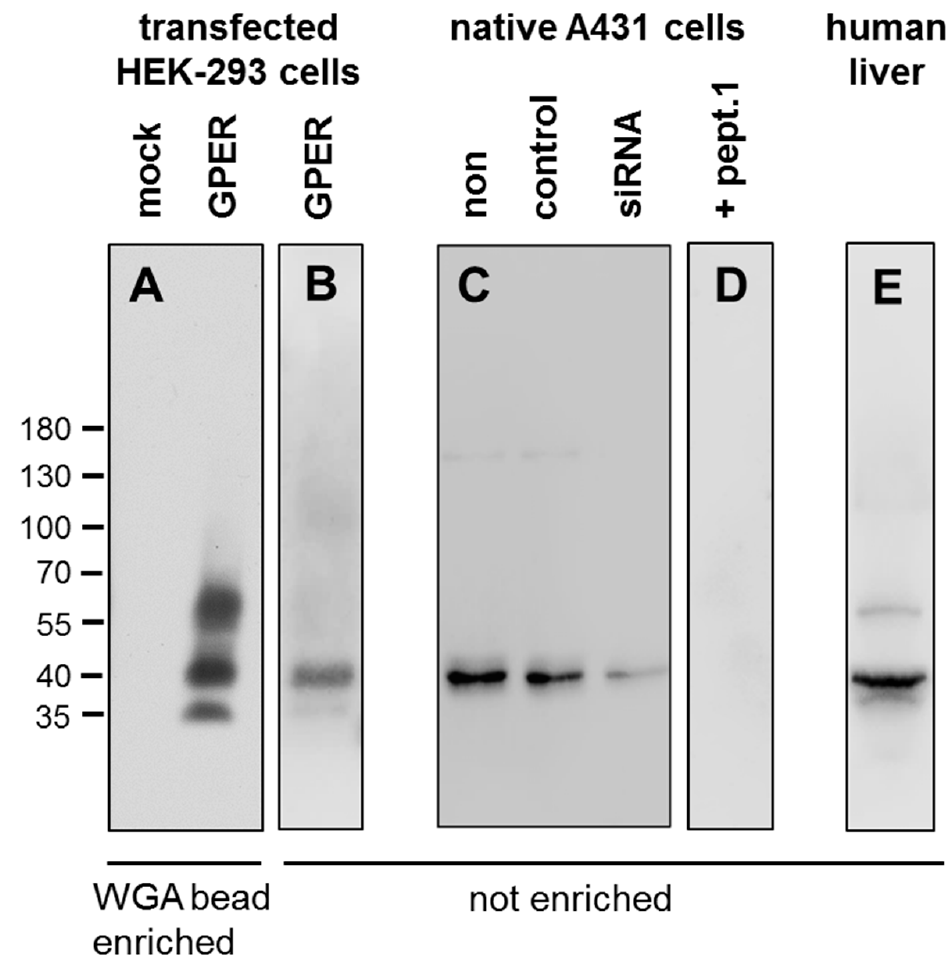
Figure 1. Characterisation of the novel rabbit anti-human GPER antibody 20H15L21 by Western blot analysis. Western blot analysis of whole-cell preparations from mock- or stably GPER-transfected HEK-293 cells ( A , B ), A321 cells ( C , D ) or normal human liver ( E ). GPER receptors were either enriched using wheat germ lectin agarose (WGA) beads ( A ) or not enriched ( B – E ). Samples were separated by 7.5% sodium dodecyl sulfate-polyacrylamide gel electrophoresis and blotted onto polyvinylidene difluoride membranes. The membranes were then incubated with 20H15L21, and the blots were developed using enhanced chemiluminescence. The relative migration of protein molecular weight markers is indicated (in kDa). Note that the novel anti-GPER antibody 20H15L21 selectively detected only the targeted GPER receptor and did not cross-react with other membrane proteins. ( C ) For further analysis of the specificity of the novel antibody, GPER expression was silenced in A431 cells endogenously expressing GPER using a GPER-specific siRNA (siRNA). Here, a distinct reduction of the immunosignal after incubation of the cells with the specific siRNA in comparison with non- transfected cells (non) or those transfected with the empty vector (control) was noted. ( D ) For an additional adsorption control, the anti-GPER antibody was preincubated for 2 h with 10 µ g/mL of the peptide used for the immunisation of the rabbit (+ pept.1). Here, a complete extinction of the immunosignal was observed. Representative results from one of three independent experiments are shown.